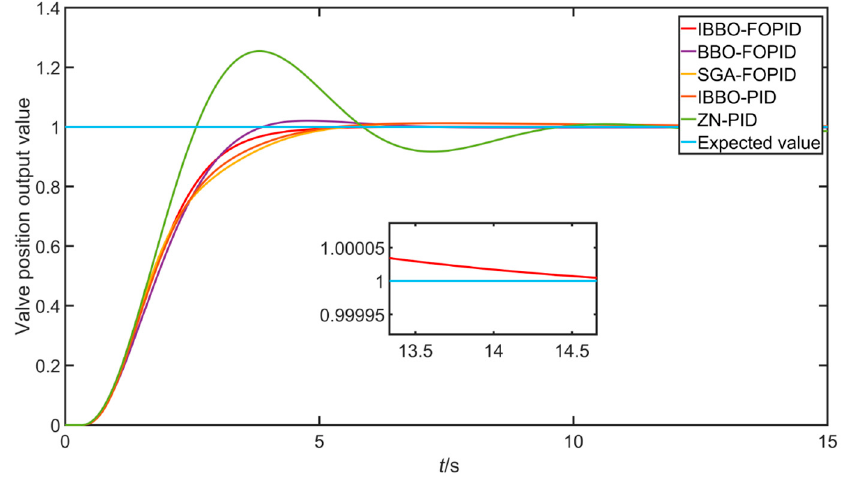
Figure 15. Comparison of step responses of different algorithms. Table 3. Comparison of performance indicators of five algorithms.